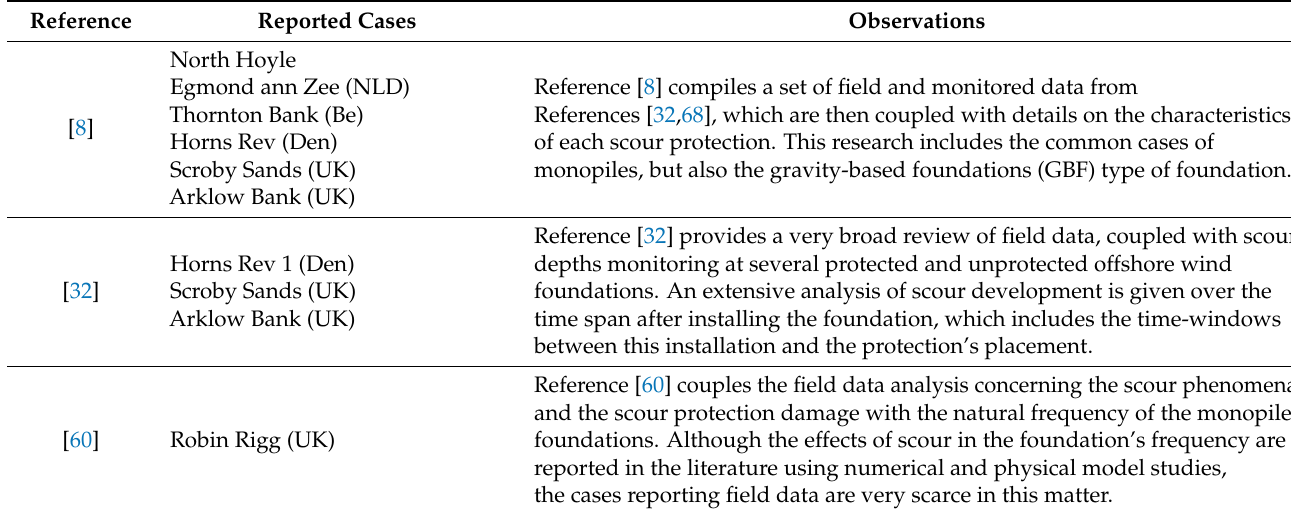
Table 2. Examples of recent case studies reported with monitoring and field data concerning scour protected offshore wind